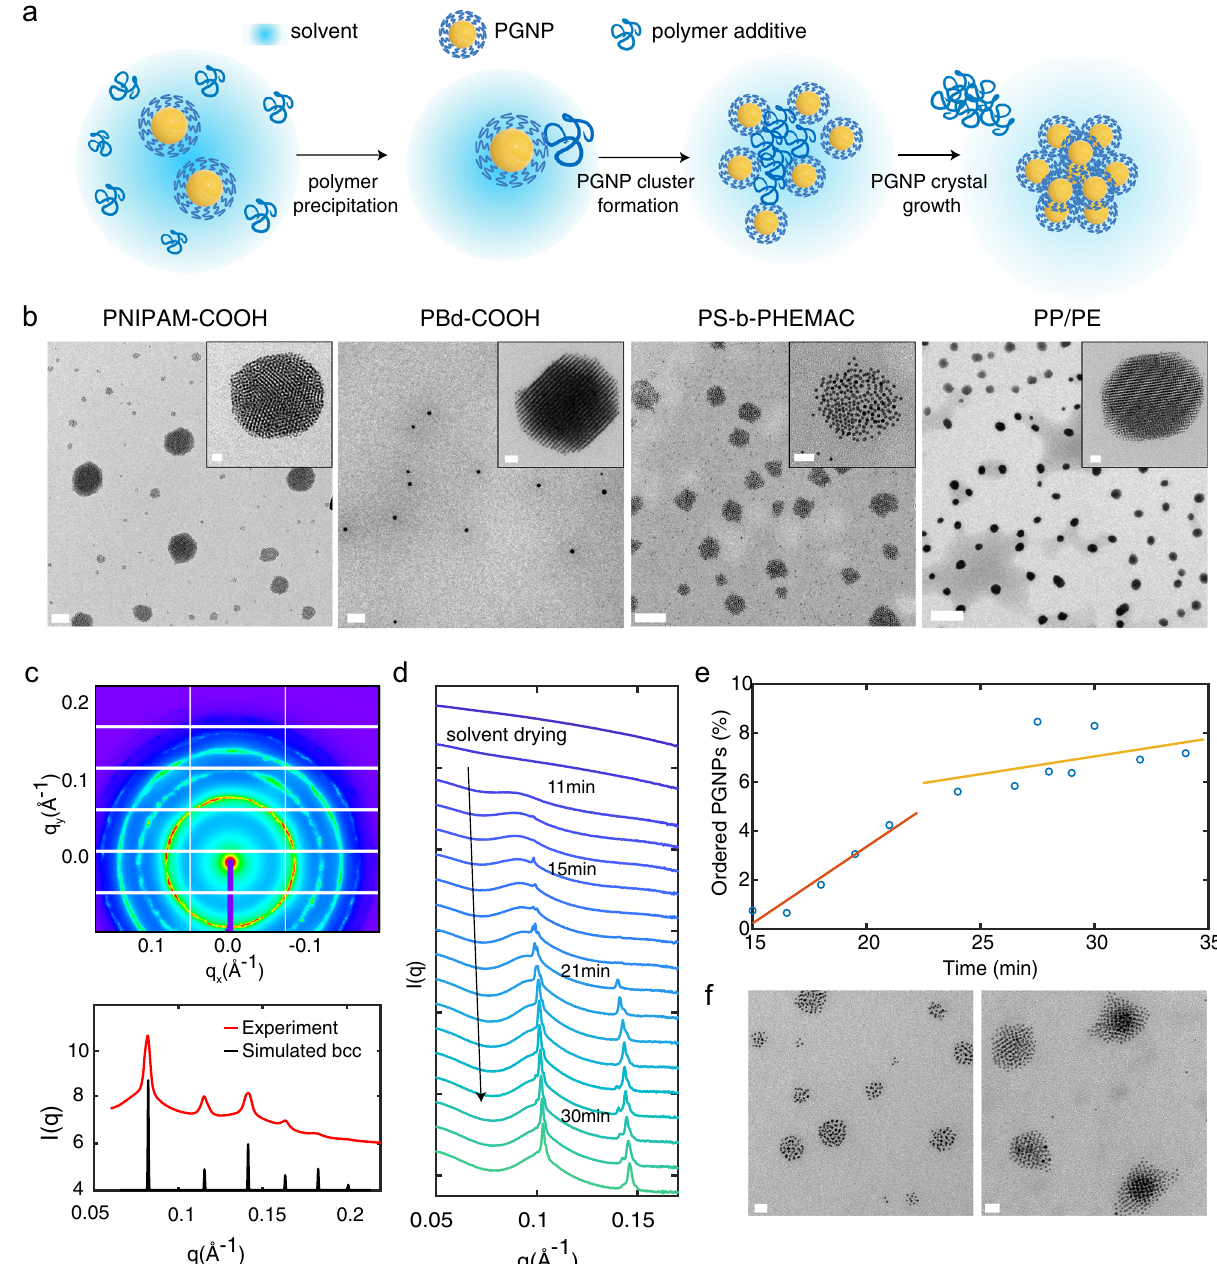
Fig. 1 Polymer precipitation-induced PGNP crystallization in solution during solvent evaporation. a Schematic of polymer precipitant-induced PGNP crystallization: the added polymers precipitate onto PGNP surfaces to form small PGNP clusters that grow into crystals. b Representative TEM images of PGNP assemblies of (1.7k) Au-PS 0.70 NPs with various polymer precipitants. See “ Methods ” for detailed polymer information. Scale bars are 100 nm for PNIPAM-COOH and PS-b-PHEMAC, 1 μ m for PBd-COOH and PP/PE, and 20 nm for all inset images. c SAXS results of PGNP crystals in a toluene solution of (5.3k) Au-PS 0.60 NPs with PP/PE. A simulated scattering pro fi le of a perfect bcc lattice is shown for reference. d In situ SAXS studies of toluene solutions of (1.7k) Au-PS 0.70 NPs and PP/PE during the drying process. Plots are offset for clarity. e PGNP crystal growth in a toluene solution of (1.7k) Au-PS 0.70 NPs and PP/PE over time. Data points re fl ect the peak integration ratio between the sharp diffraction peak at q ~ 0.1 Å − 1 in d from PGNPs in crystals and the broad peak from PGNPs in the solution. f TEM images of (1.7k) Au-PS 0.70 NP assemblies with PP/PE upon fast solvent removal. Scale bars are 20 nm. PGNPs were dispersed at + NP ¼ 0 : 1vol : % with + PP = PE = 0 : 08vol : % and all other polymers at + polymer = 0 : 2vol : %